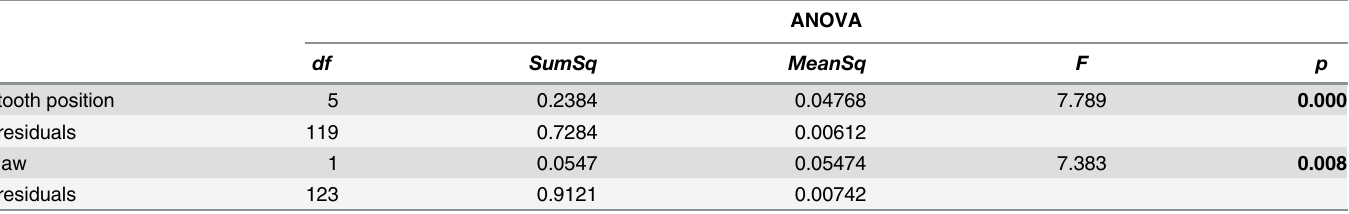
Table 3. Results of one-way ANOVA with tooth position or jaw as factor and relative enamel content as the numeric variable. Values in bold indicate a significant interaction ( p (cid:1) 0.05). Statistics abbreviations: df = degree of freedom, SumSq = sum of squares, MeanSq = mean of squares, F = test value, p = significance level.